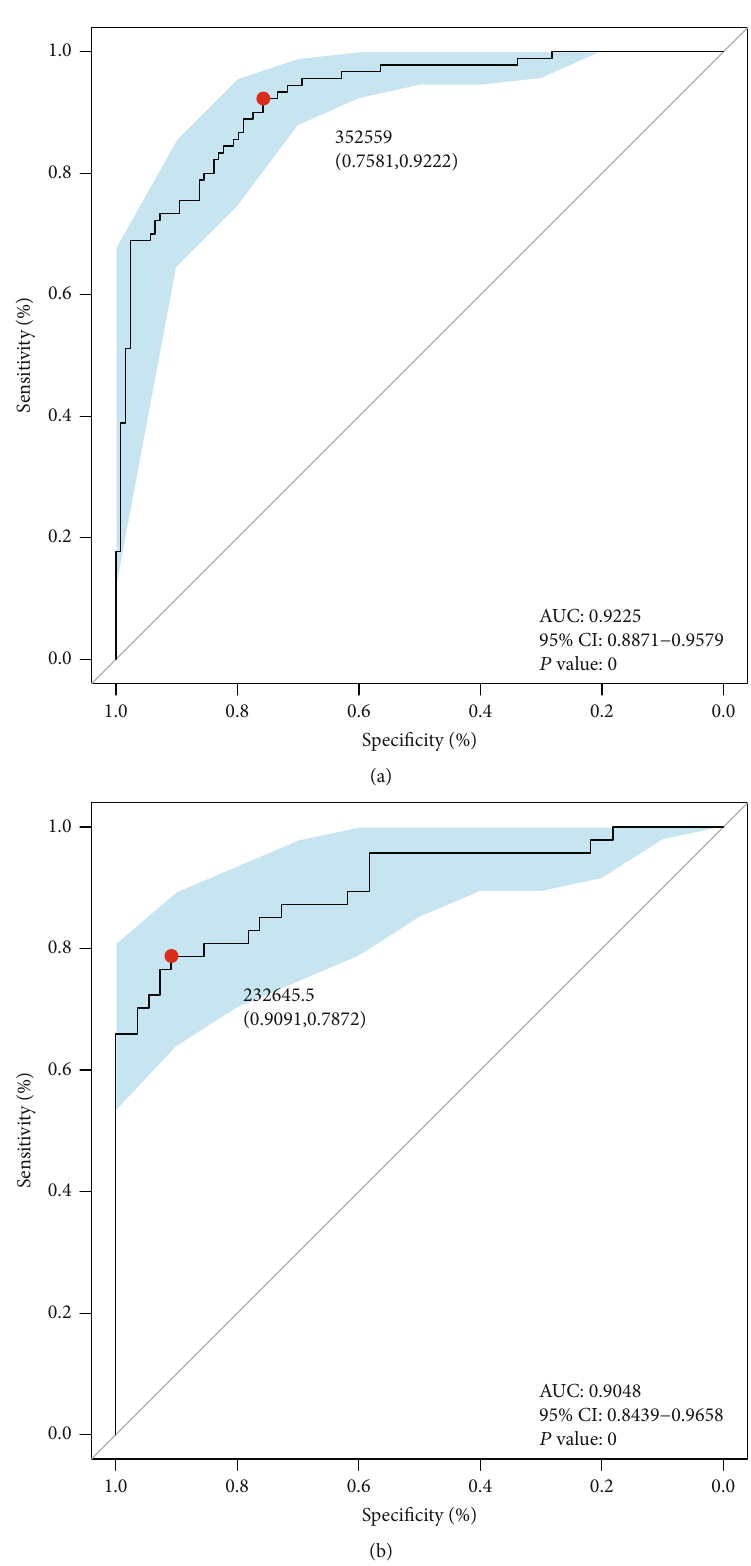
Figure 3: Di ff erential capability based on obtained OTUs. (a) ROC curves based on obtained microbial markers showing discrimination rate for DM and Con in the training set. AUC, 95% CI, and P value were listed in the graph. (b) ROC curves based on obtained microbial markers showing discrimination rate for DM and Con in the test set. AUC, 95% CI, and P value were listed in the graph. ROC: receiver operating characteristic curve; AUC: area under the curve; CI: con fi dence